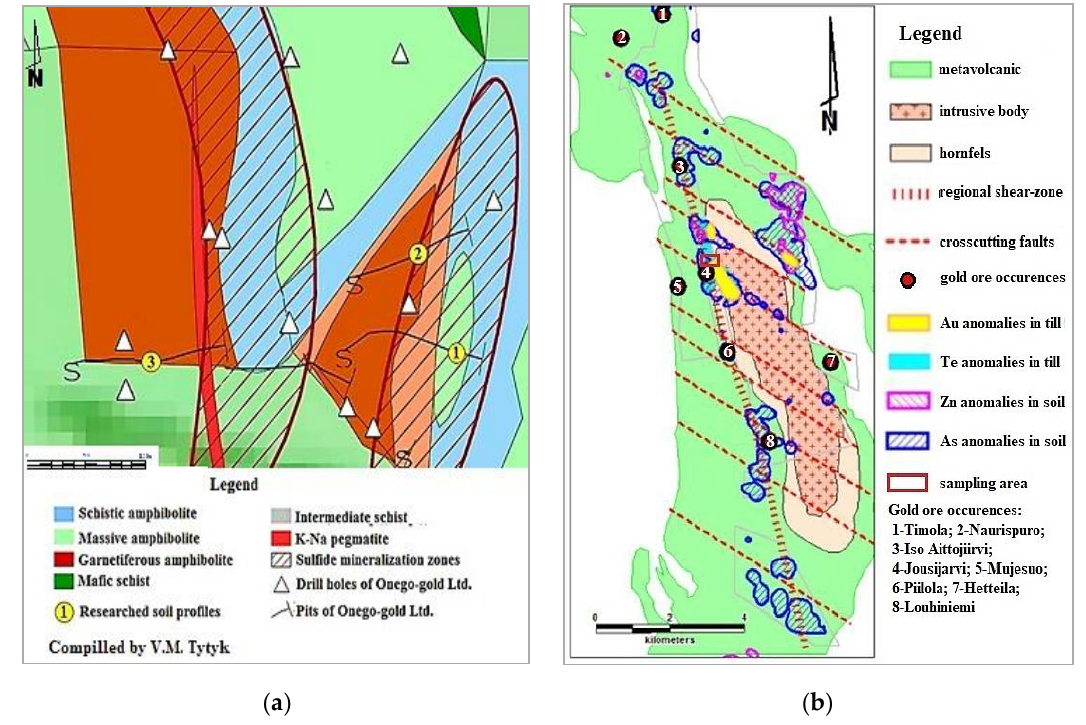
Figure 2. Places of sampling in the Novye Peski ( a ) and Piilola ( b ) [14] areas.